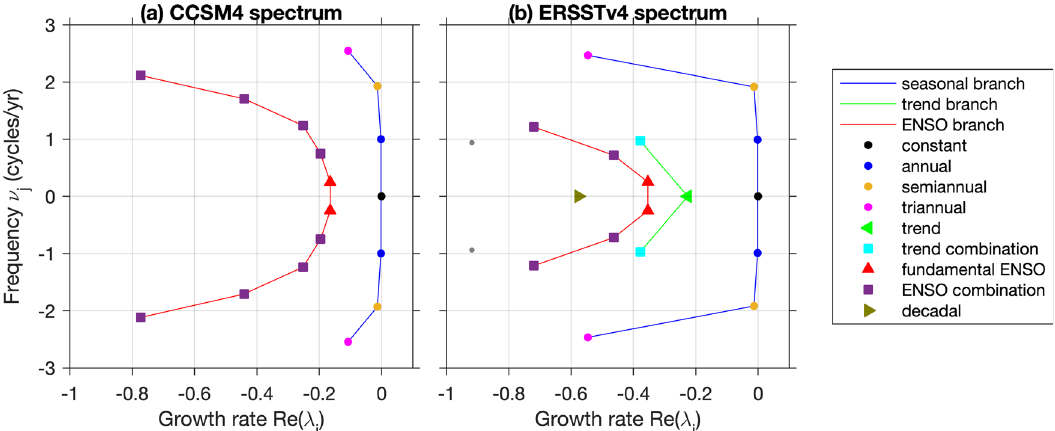
Fig. 3 Leading generator eigenvalues λ j computed from CCSM4 (a) and ERSSTv4 (b) Indo-Paci fi c SST data, highlighting eigenvalues corresponding to seasonal, interannual, decadal, and trend modes. The vertical and horizontal axes show the frequency ν j ¼ Im λ j = ð 2 π Þ and growth rate, Re λ j , respectively. Note that complex eigenvalues occur in complex-conjugate pairs as appropriate for describing oscillatory signals at the corresponding eigenfrequencies. Moreover, negative values of Re λ j correspond to decay. Lines connecting eigenvalues serve as visual guides for the seasonal (periodic), trend, and ENSO branches of the spectra. The annual (dark blue) and ENSO (red) eigenfrequencies indicated in the spectra correspond, through their imaginary parts, to the frequencies ν annual and ν ENSO discussed in the main text. Note that decadal modes are present in the CCSM4 spectrum, but they have larger decay rates, (cid:1) Re λ j , than the range depicted in a . See Supplementary Table 3 for a listing of the leading 25 generator eigenvalues extracted from CCSM4 and